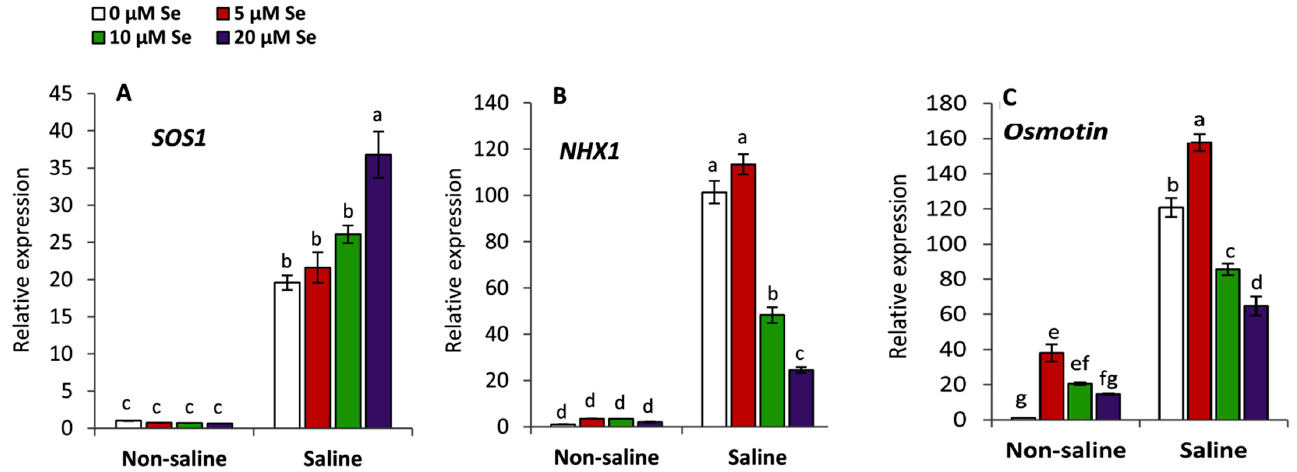
Figure 8. Effect of Se supplementation at 5, 10 and 20 µM on relative expression of salt stress responsive genes. SOS1 ( A ), NHX1 ( B ) and Osmotin ( C ) of non-stressed and salt-stressed (50 mM NaCl) snap bean seedlings (28 days after sowing). The results are expressed as mean values of three measurements ± SE using Duncan’s multiple range test ( p = 0.05). Different letters indicate significant differences among the treatments.